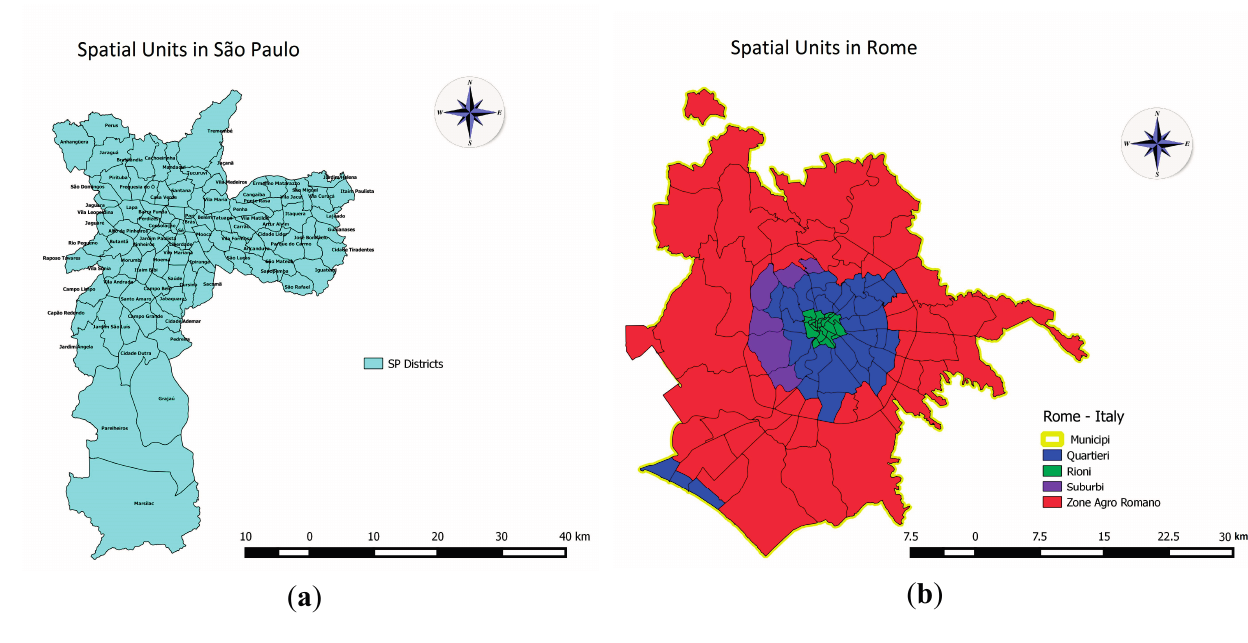
Figure 3. Spatial units: ( a ) São Paulo; and ( b ) Rome.